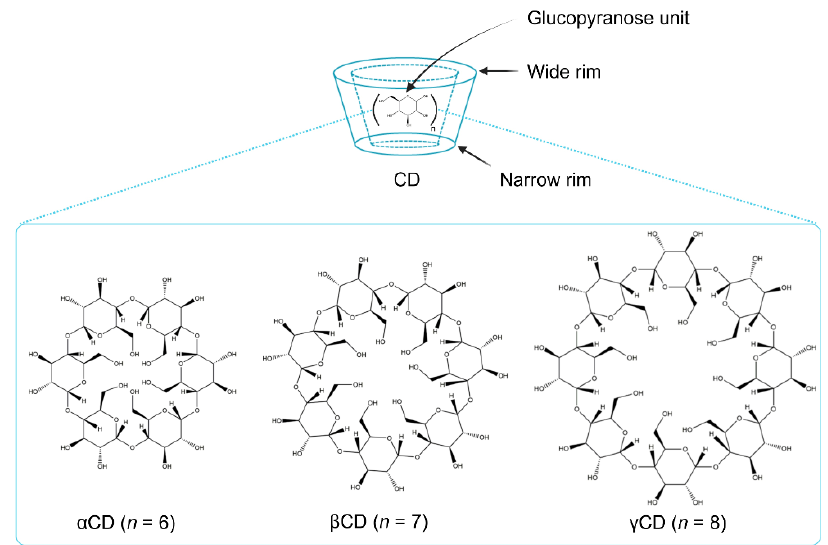
Figure 2. Schematic presentation of the parent CDs (created with Biorender.com). Table 1. Physicochemical properties of natural CDs and selected CD-derivatives of pharmaceutical interest .